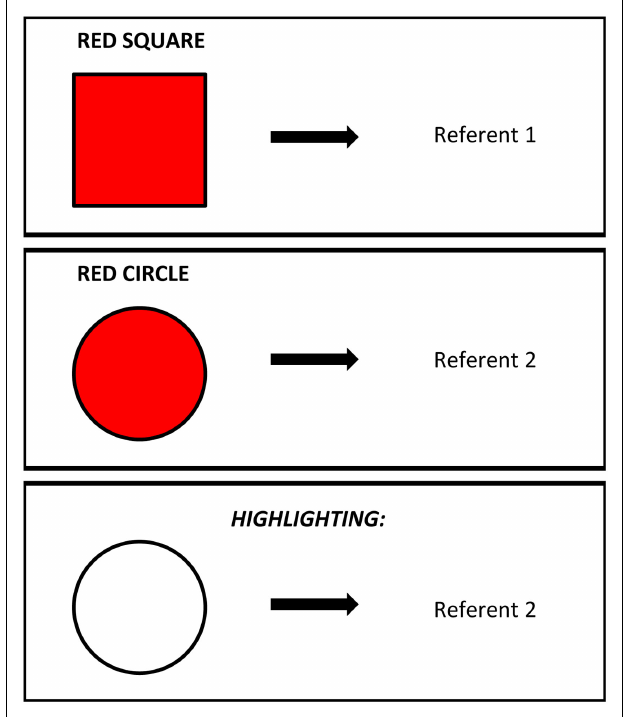
FIGURE 2 | Example of referential prediction via